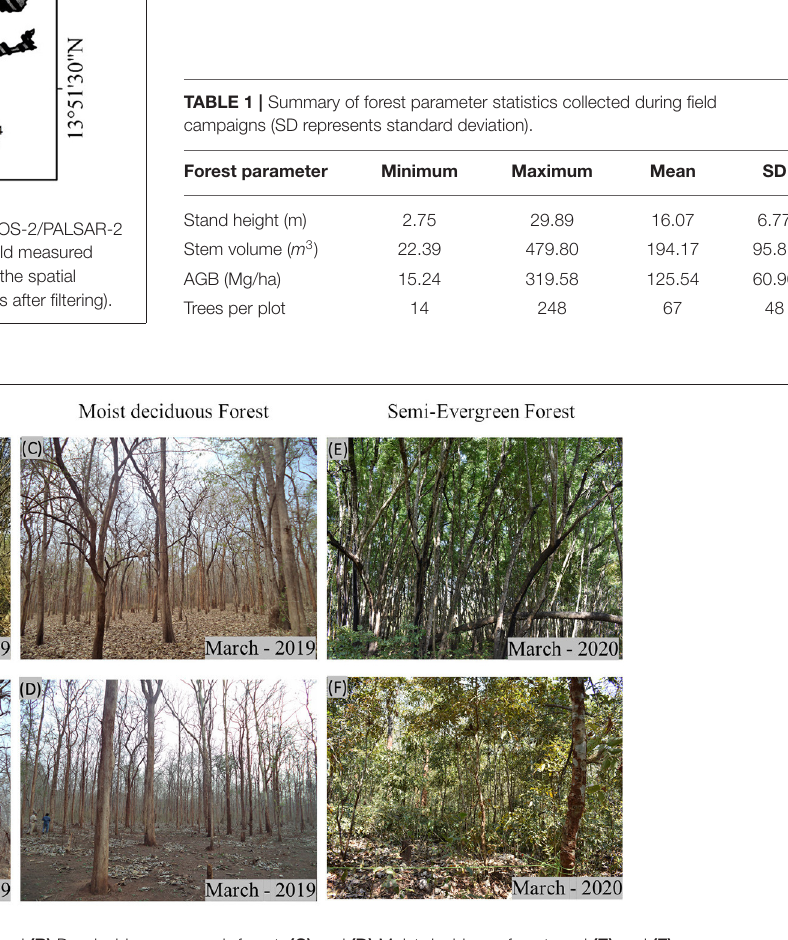
Frontiers in Forests and Global Change |